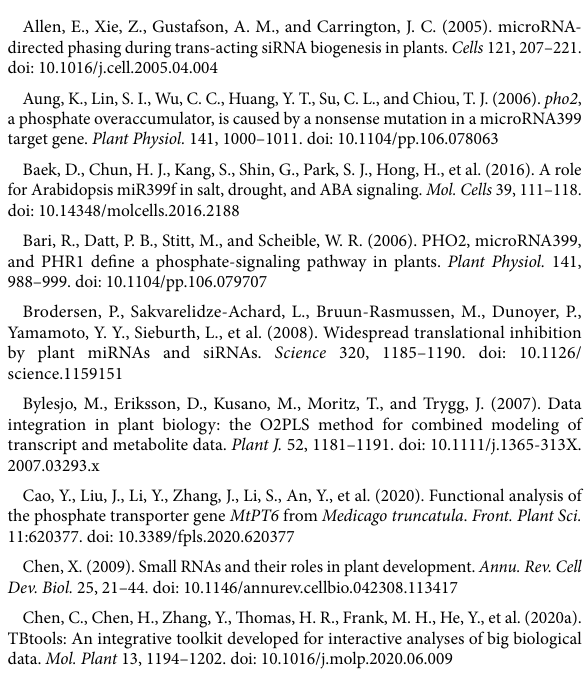
SUPPLEMENTARY TABLE 3A Differentially expressed mRNAs in root under phosphate deficiency. SUPPLEMENTARY TABLE 3B GO enrichment of differentially expressed mRNAs. SUPPLEMENTARY TABLE 3C The functions of Differentially expressed mRNAs enriched by MapMan. SUPPLEMENTARY TABLE 4 Differentially expressed miRNAs in root under deficient phosphate. SUPPLEMENTARY TABLE 5A miRNA targets predicted by RNAhybrid. SUPPLEMENTARY TABLE 5B miRNA targets predicted by psRNATarget. SUPPLEMENTARY TABLE 5C miRNA targets predicted by Targetfinder. SUPPLEMENTARY TABLE 5D All of miRNA targets predicted by RNAhybrid, psRNATarget and Targetfinder. SUPPLEMENTARY TABLE 6 Correlation analysis of miRNA and mRNA. SUPPLEMENTARY TABLE 7A The function of miRNA-targeted mRNAs enriched by GO analysis. SUPPLEMENTARY TABLE 7B The function of miRNA-targeted mRNAs enriched by KEGG analysis. SUPPLEMENTARY FIGURE 1 MapMan enrichment of differentially expressed genes in alfalfa root under Pi deficiency. SUPPLEMENTARY FIGURE 2 The expression of miRNAs and their targets mRNA under Pi deficiency. SUPPLEMENTARY FIGURE 3 Gene ontology enrichment of miRNA-targeted mRNAs under Pi deficiency. SUPPLEMENTARY FIGURE 4 Kyoto Encyclopedia of Genes and Genomes pathways of miRNA- targeted mRNAs under Pi